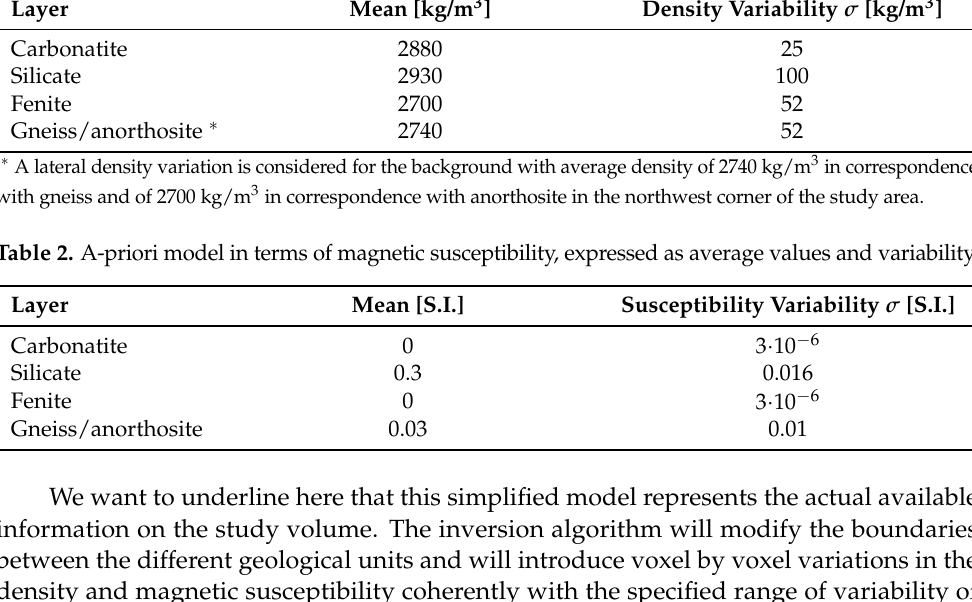
Table 1. A-priori model in terms of density, expressed as average values and variability. Layer Mean [kg/m 3 ] Carbonatite